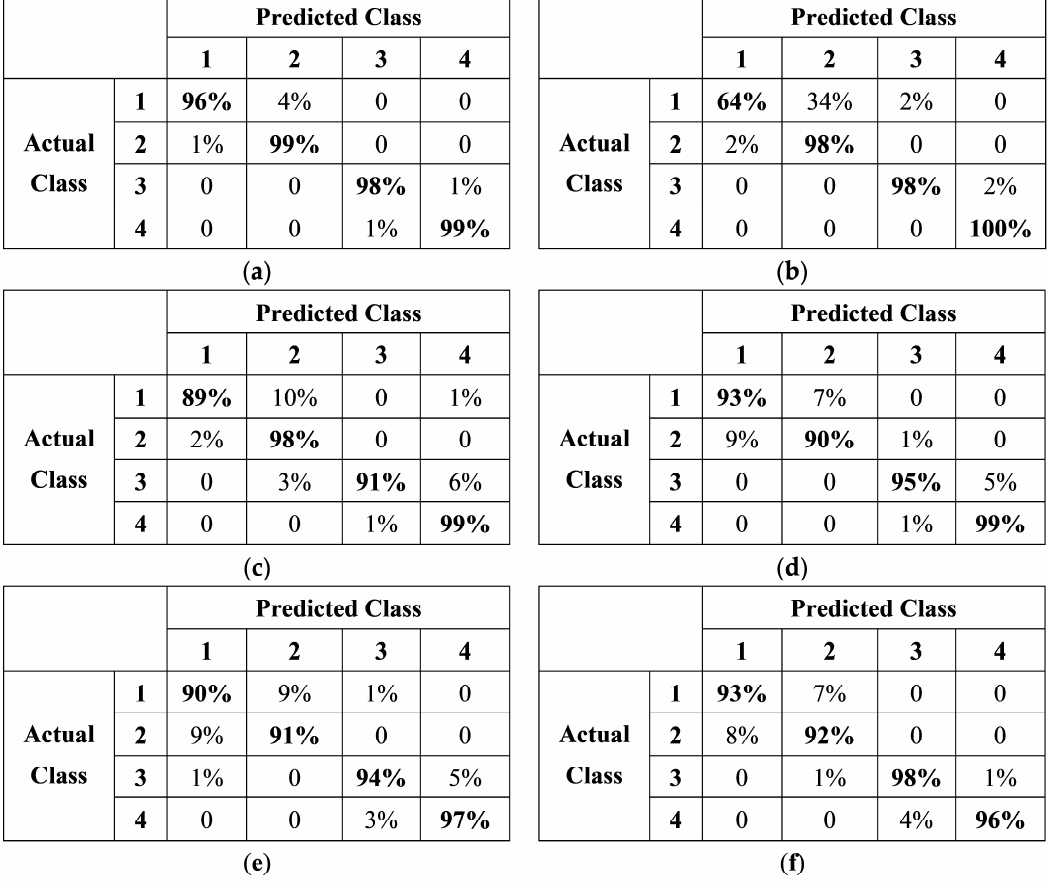
Figure 5. The confusion matrixes of ( a ) VGG16, ( b ) ResNet50, ( c ) InceptionV3, ( d ) NasNet-Mobile, ( e ) EfficientNetB0, and ( f ) MobileNetV2 applied on testing dataset. Table 2. The testing accuracy, average detection time, and model size of VGG16, ResNet50, Incep- tionV3, NasNet-Mobile, EfficientNetB0, and